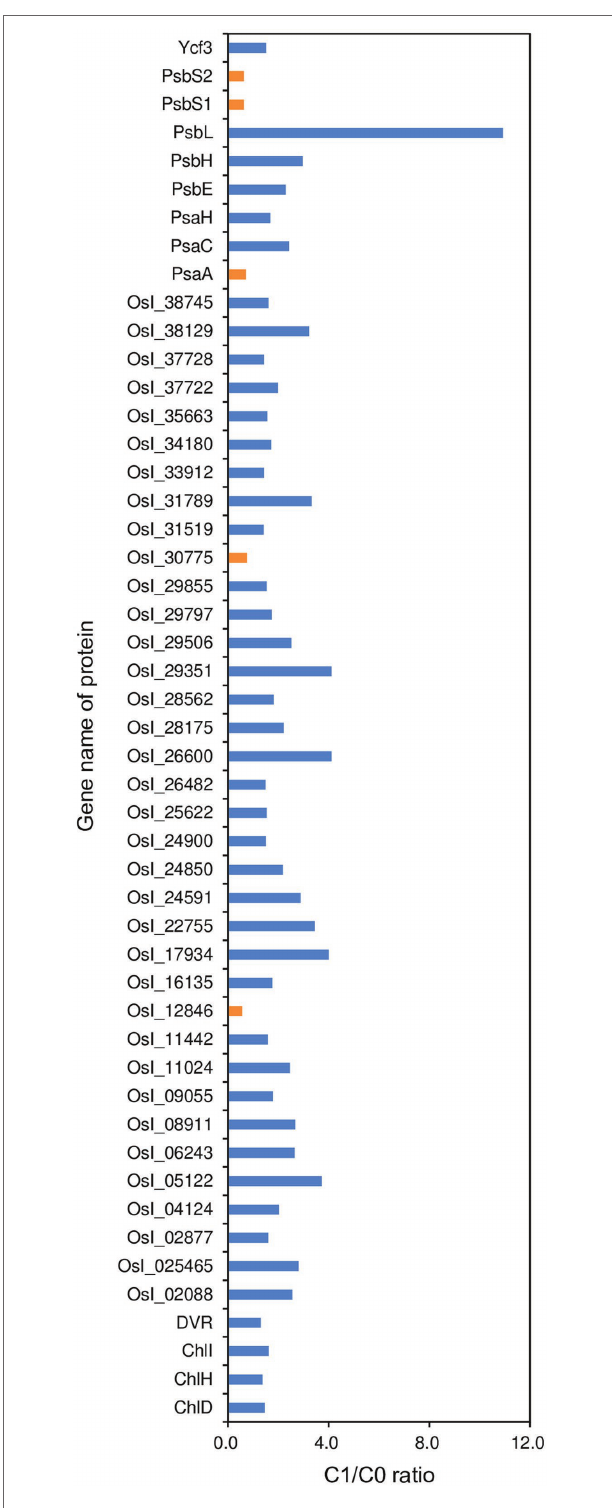
FIGURE 7 | Fold changes in differentially modulated proteins related to photosystems I and II in leaves of rice plants grown with biochar application (C1) compared to plants grown without biochar application (C0). Orange and blue bars represent the down- and up-modulated proteins in the C1 treatment compared to the C0 treatment,